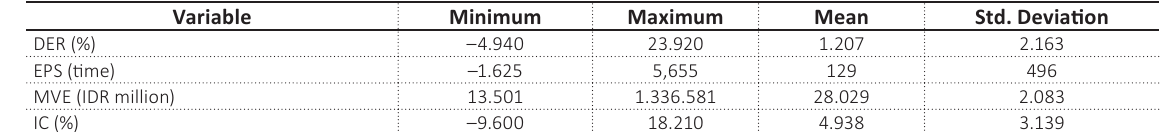
Table 2. Descriptive statistics of